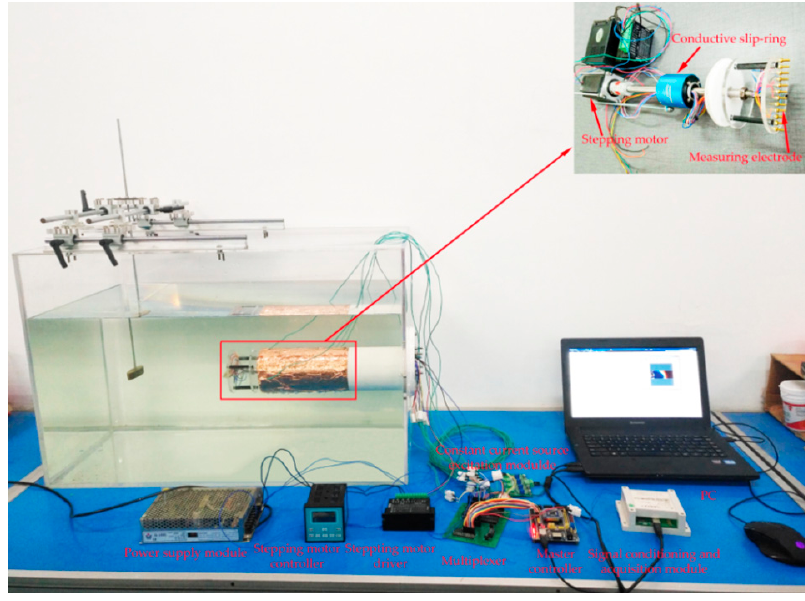
Figure 4. The diagram of the physical model test device.